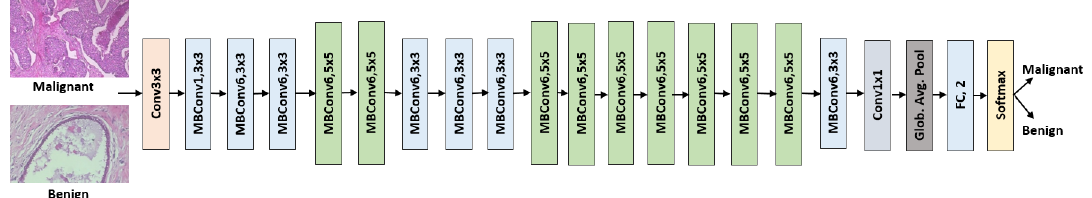
Figure 3. EfficientNet B0 CNN